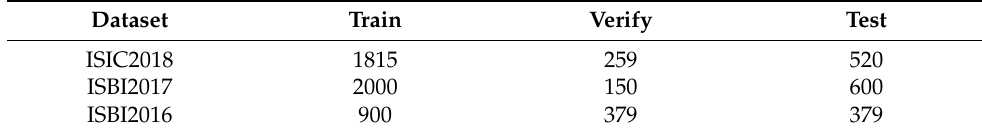
Table 1. The distribution of the dataset.